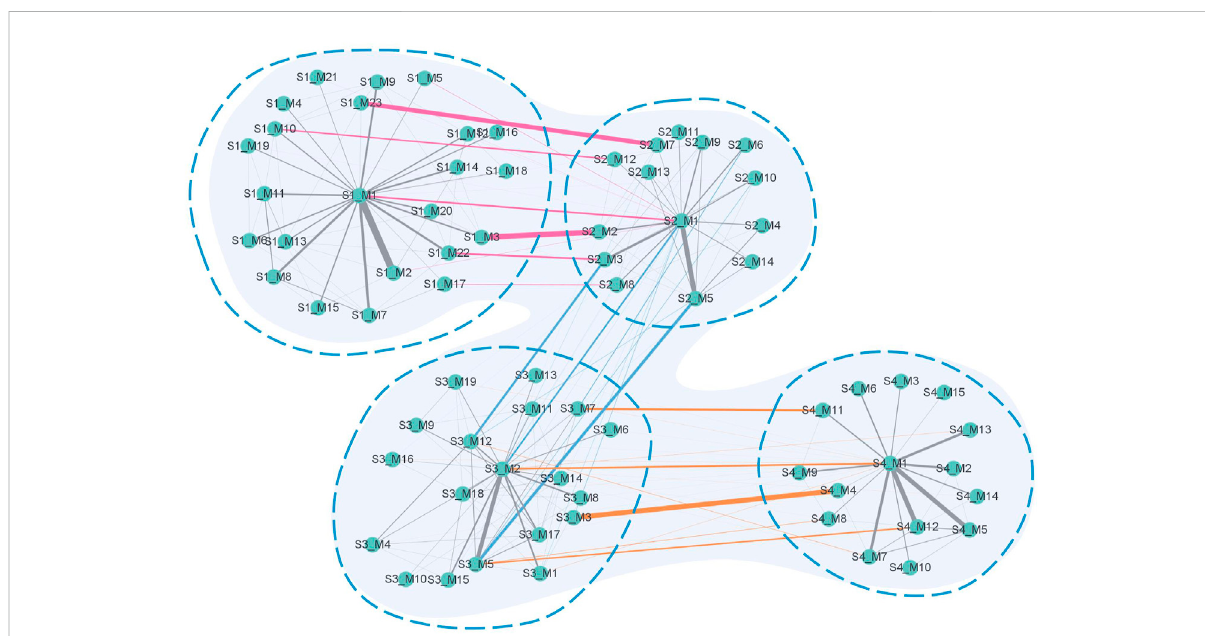
FIGURE 9 Globalmodulenetwork.Thenetworkcontainsfourpartscorrespondingtothefourstagesofthedisease.Informationontheverticescontainsa number after the letter S , representing the stage serial number, and a number after letter M , representing the serial number of the module in each stage. Pink edges connect modules between S 1 and S 2, blue edges connect modules between S 2 and S 3, and orange edges connect modules between S 3and S 4.Thegrayedgesconnectmodulesineachstage.ThewidthoftheedgerepresentsthevalueoftheJaccardcoef fi cientofthe biological molecules in the connected